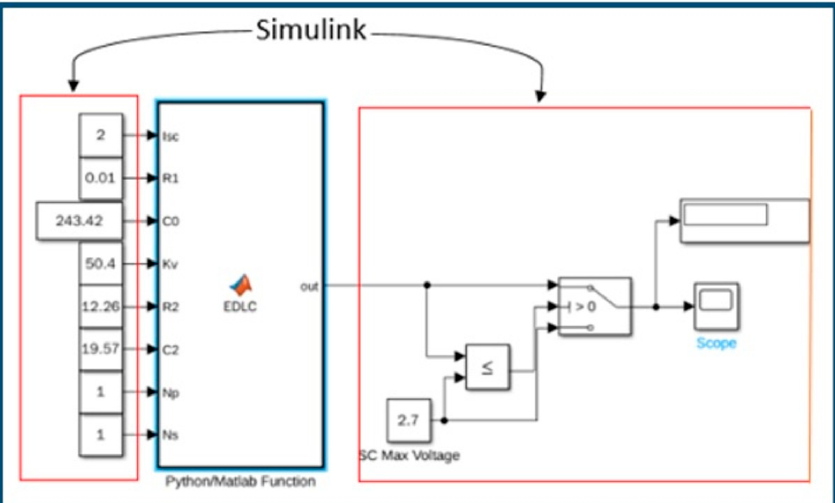
Figure 5. Python/MATLAB/Simulink (PMS) model.